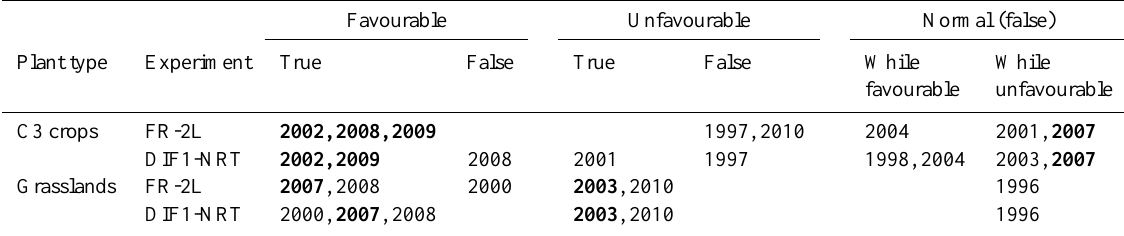
Table 4. Correspondence between simulated and observed extreme years for départements with significant correlations ( R 2 ) at the 1% level with both the FR-2L and DIF1-NRT simulations for C3 crops and grasslands as shown in Fig. 10. Favourable (unfavourable) years are defined or A S,DMY higher (lower) than 1.0 ( − 1.0). Years with A S,DMY higher (lower) than 1.5 ( − 1.5) are in as z scores A S ,B ag X